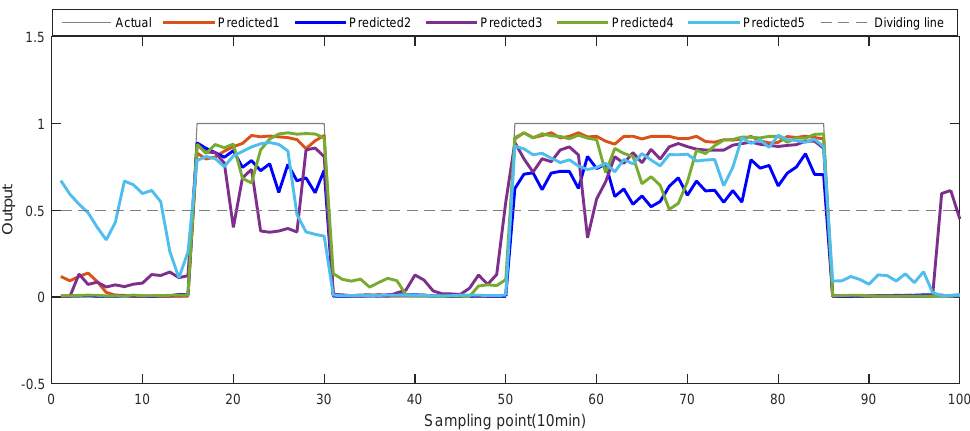
Figure 15. Output values of five test